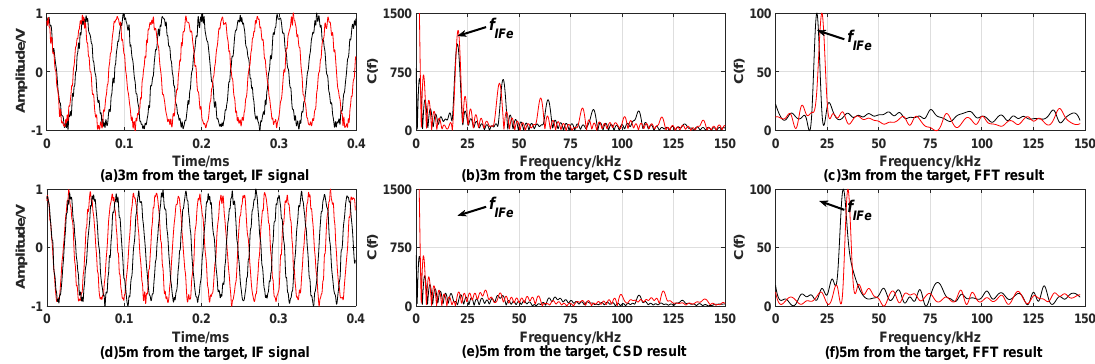
Figure 3. Simulation results when expected distance is 3 m without smoke interference. When fuze is 3 m away from the target, ( a ) is time domain waveform of the IF signal; the processing results of CSD algorithm and FFT algorithm are ( b , c ), respectively. When fuze is 5 m away from the target, ( d ) is time domain waveform of IF signal; the processing results of CSD algorithm and FFT algorithm are ( e , f ), respectively.